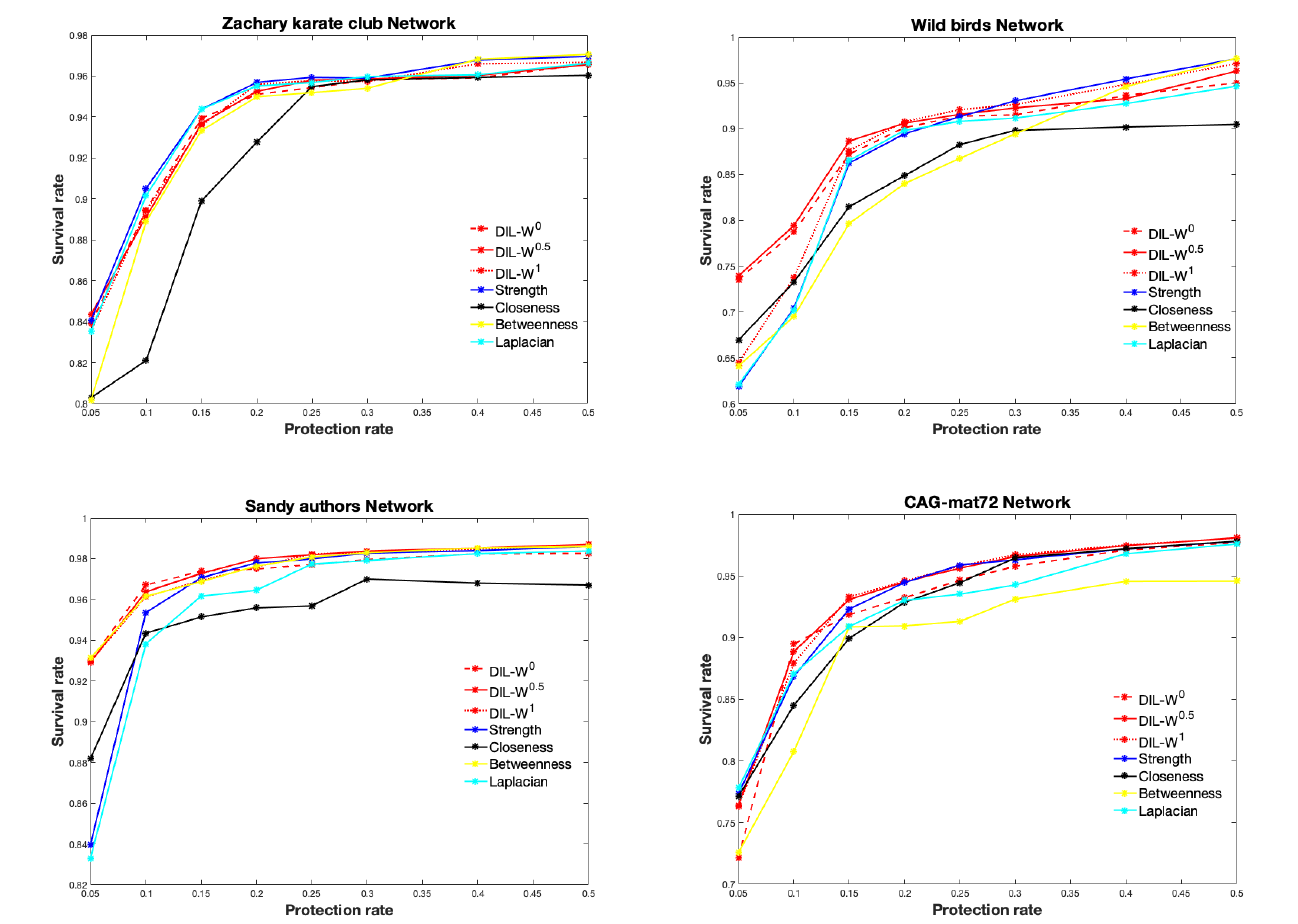
Figure 3. σ as a function of k on each